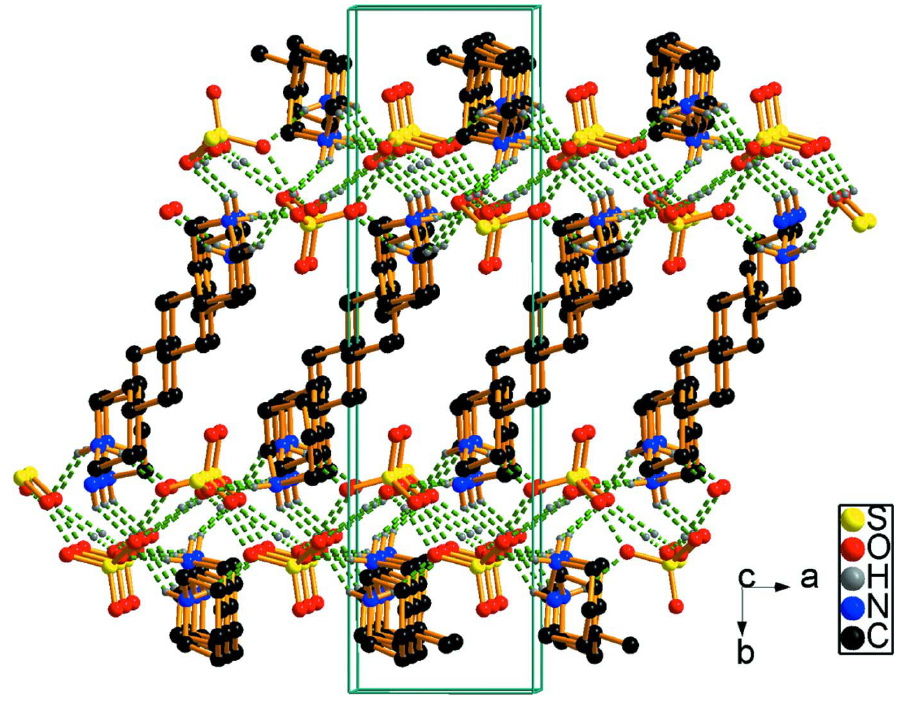
Figure 2 The three-dimensional structure of the title compound, showing the hydrogen bonding interactions (dashed